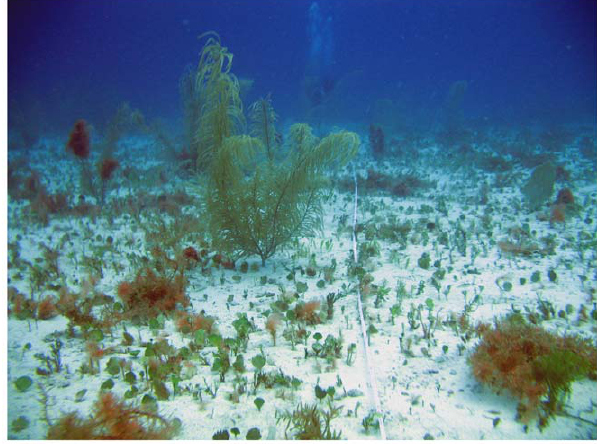
Figure 6. Low-diversity gorgonian assemblage on the Saba Bank plateau. An image from one of the ‘‘E’’ sites in the Saba Bank plateau region shows a large sea plume ( , 1.5 m- Pseudopterogorgia acerosa ) and scattered sea fans Gorgonia mariae attached to a hard carbonate platform covered with a thin veneer of sediment. The plateau region is distinct from the fore-reef, consisting of reef flat and lagoon bottom environments [4].